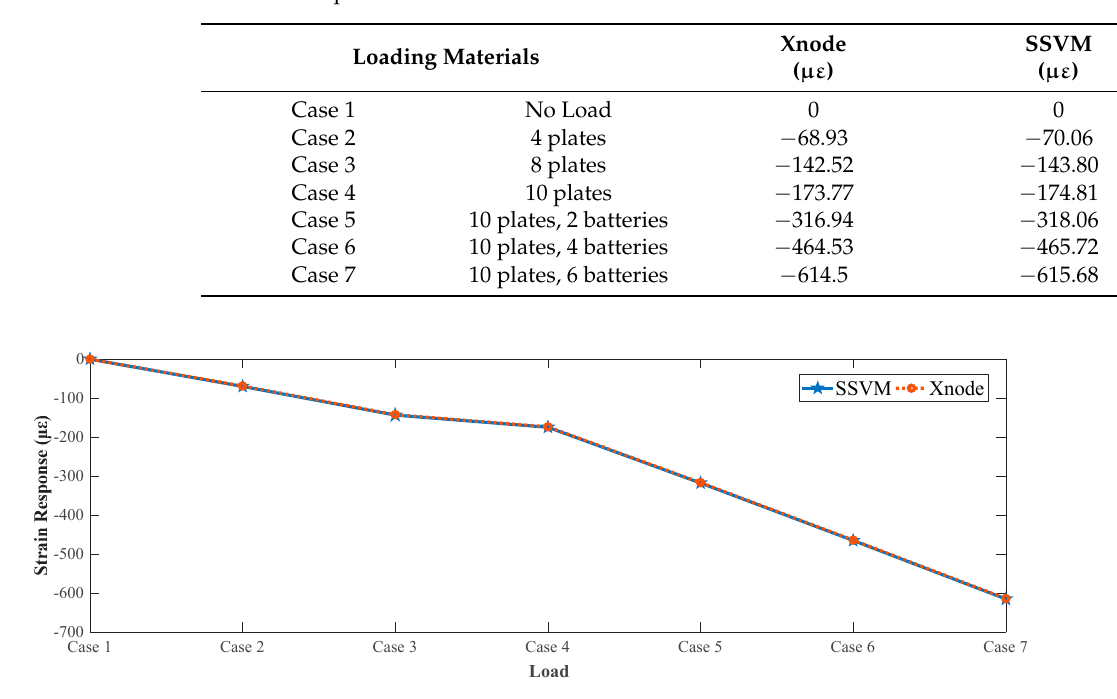
Figure 9. Strain response recorded by the proposed SSVM. Table 3. Comparison between Xnode and SSVM.